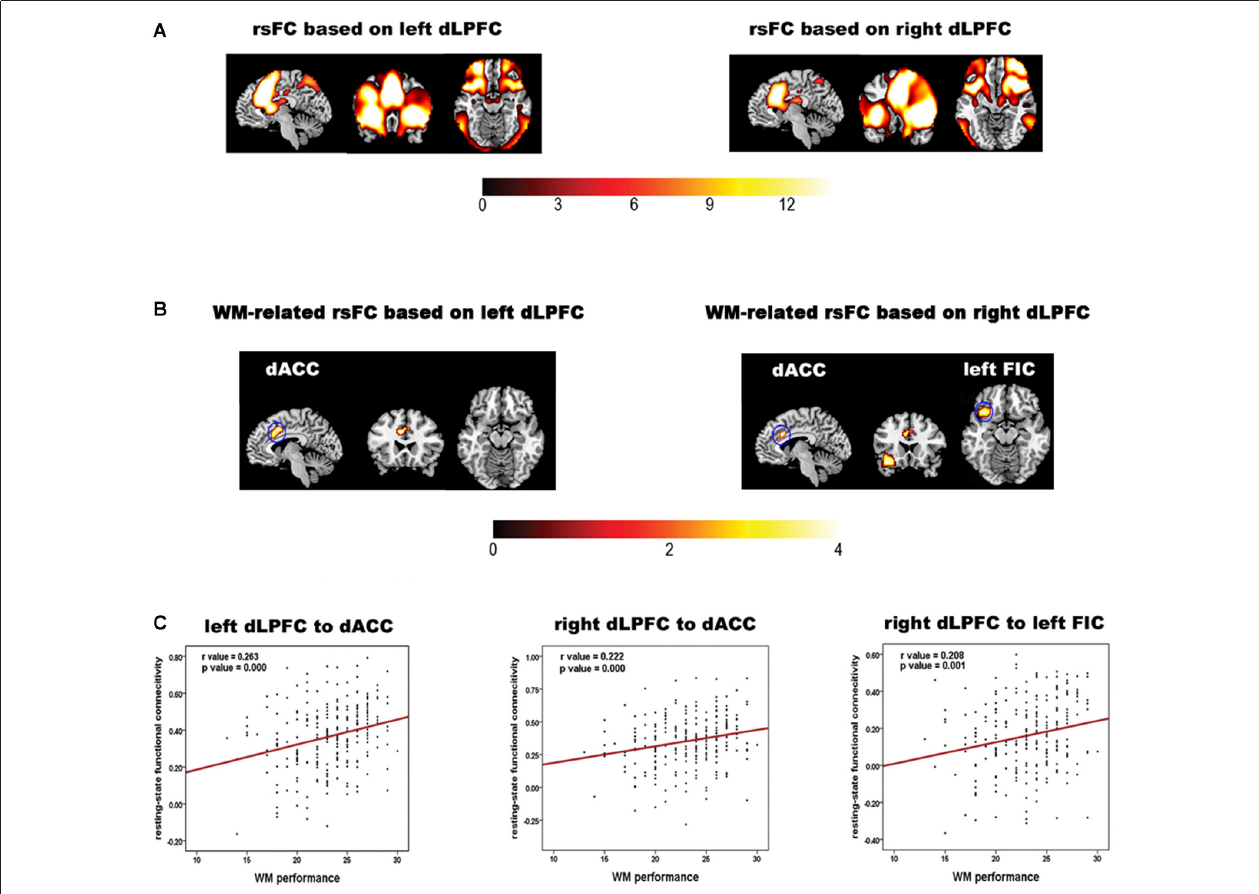
FIGURE 1 | Results of the rsFC analysis and the correlation analysis of the rsFC data and working memory (WM) performance. (A) The bilateral dLPFCs rsFC pattern obtained by one-sample t -tests for the whole group. (B) Brain regions in which the left and right dorsolateral prefrontal cortex (dLPFC) rsFC patterns in (A) are correlated with WM accuracy. The color bar indicates t values. (C) Scatter plots illustrating the correlations between WM accuracy and the strength of the rsFC between the dLPFC and each brain region in (B) . The red line indicates that the correlation was significant ( p < 0.05, corrected).